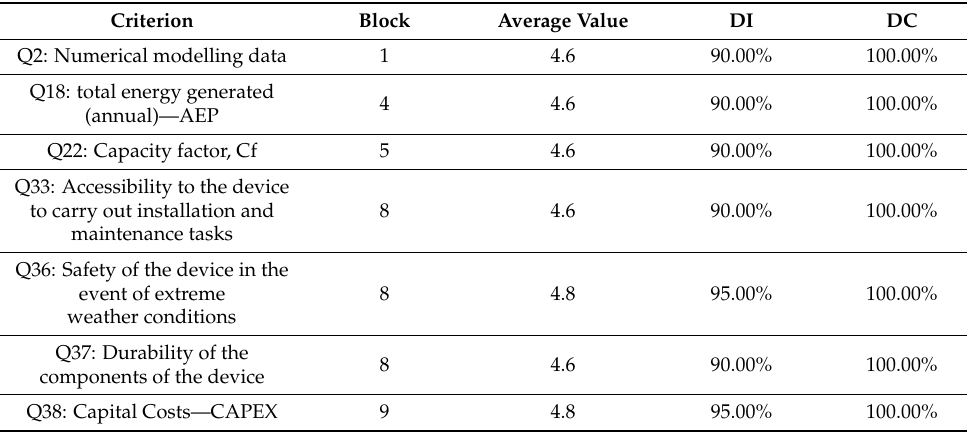
Table 9. Criteria meeting DI ≥ 90% and DC ≥ 90% values. Academia.